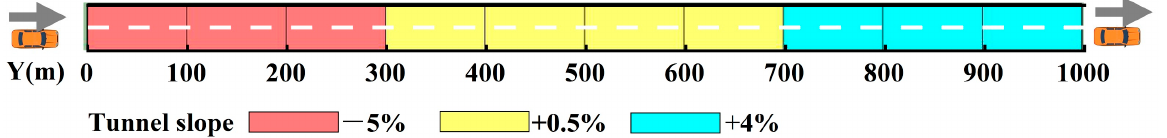
Figure 1. Schematic diagram of the shield part of the tunnel.